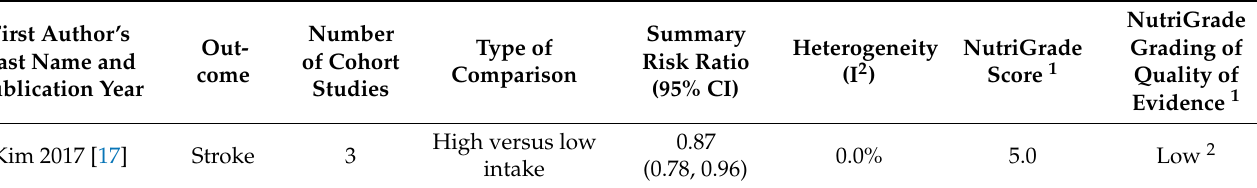
Table 5. Meta-analyses of associations between intake of unprocessed poultry and risk of stroke, and NutriGrade meta- evidence grading.